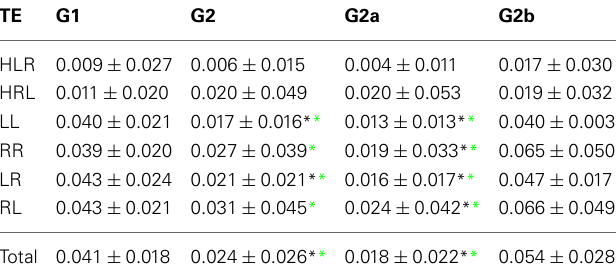
Table 3 | TE average values ± standard deviation.